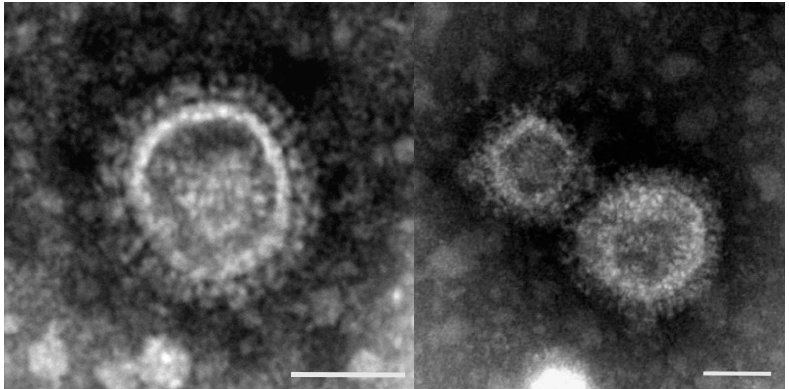
Figure 1. Corona-like particles (100–150 nm) in fecal samples of turkeys. Negative staining with phosphotungstic acid revealed that TCoVs are enveloped particles, roughly spherical, with diameters ranging from 100 to 200 nm (scale bar: 50 nm).